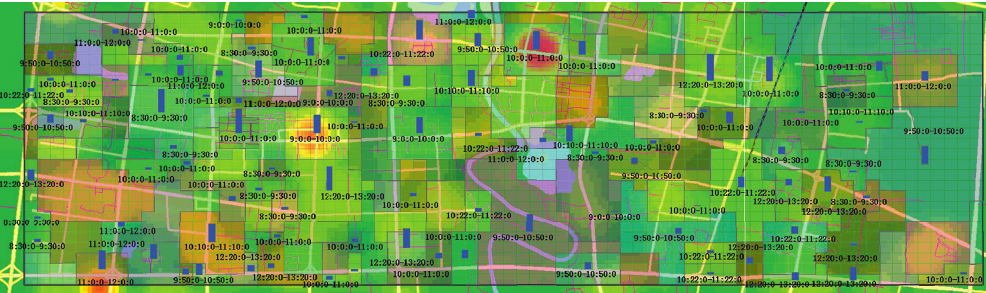
Figure 7: Peak parking hours and parking demand column for estimated parking